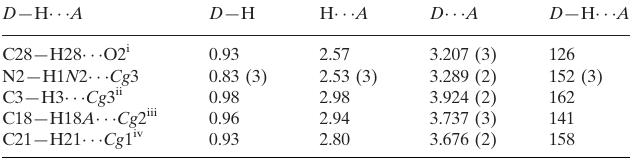
Hydrogen-bond geometry (A˚ , (cid:2)